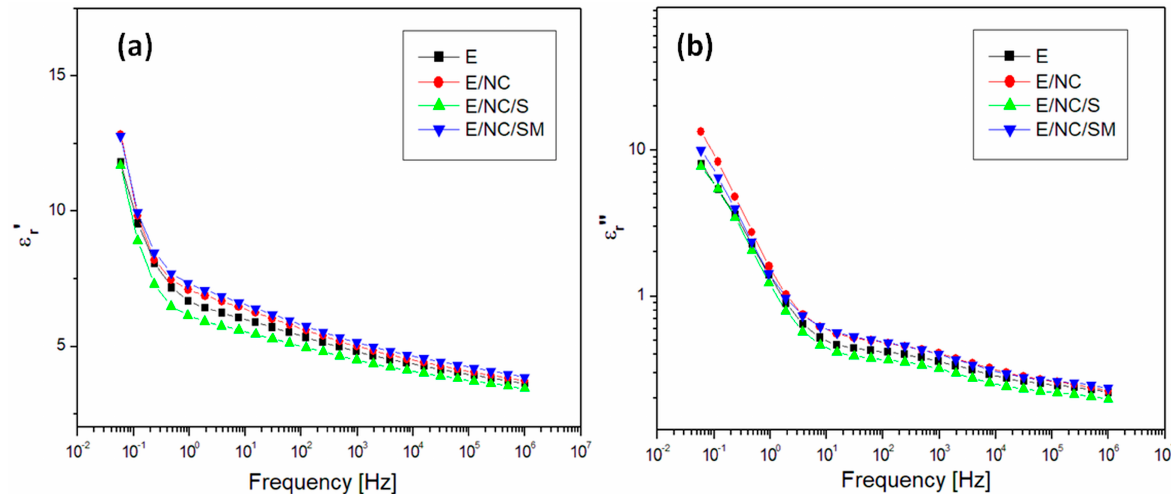
Figure 10. Dielectric spectra of bio-based epoxy and its nanocomposites: real part of the complex relative permittivity( ε r ′ ) ( a ) and imaginary part of the complex relative permittivity ( ε r ″ ) ( b ).